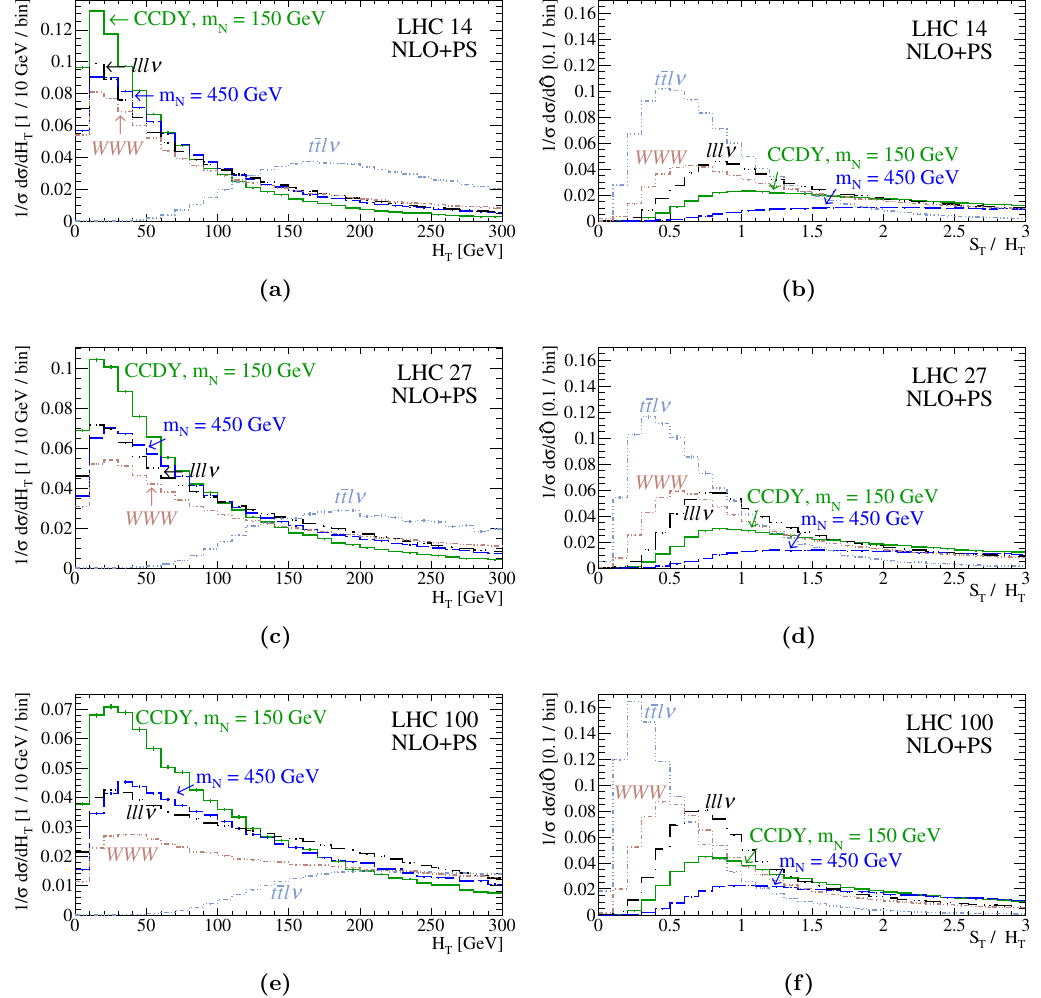
Figure 18. Same as (cid:12)gure 16 but for (a,c,e) H T as well as (b,d,f) the ratio S T =H T .